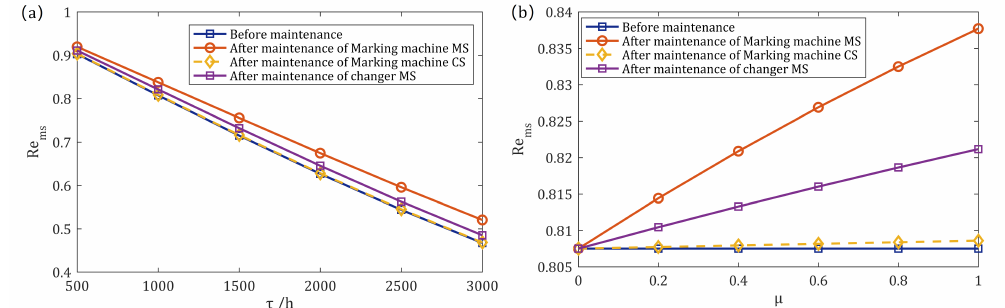
Figure 6. Reliability variations of the machining line subsystem before and after the element mainte- nance over the maintenance parameters. ( a ) Variations over the maintenance period. ( b ) Variations over the maintenance